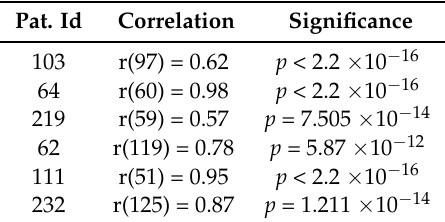
Table 6. Individual Pearson’s correlations between perceived fatigue and perceived interference for each